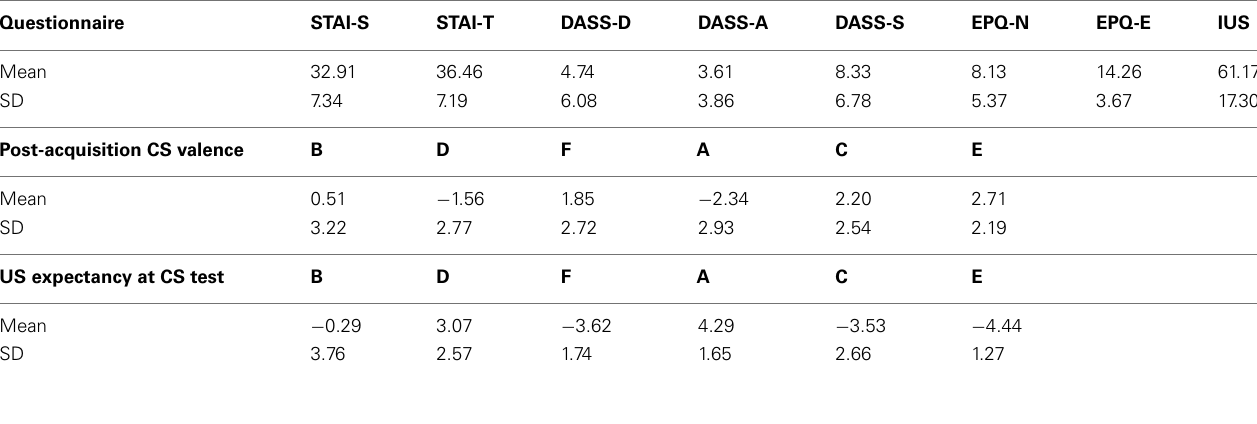
Table 2 | Mean and standard deviations (SD) for questionnaires, post-acquisition CS valence and US expectancy at CS test.